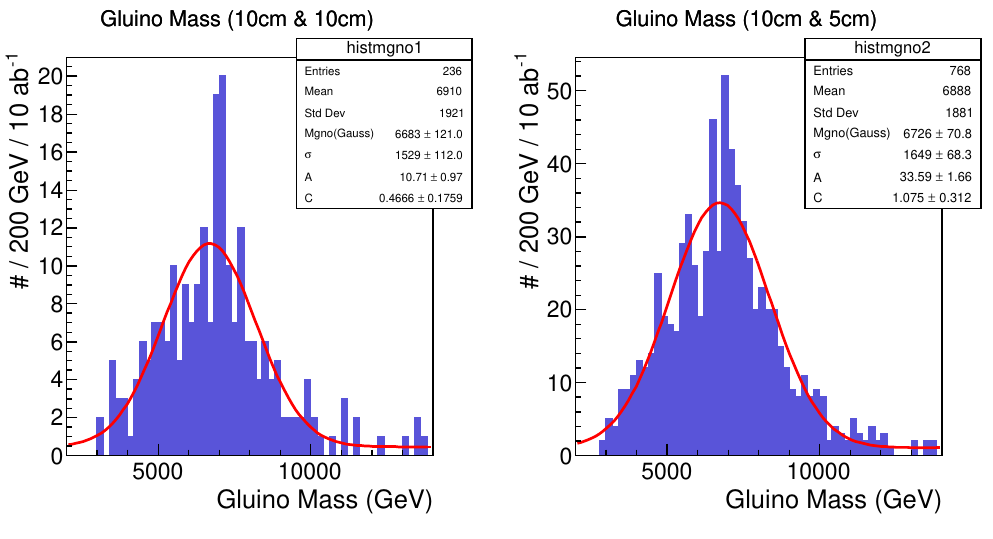
Figure 11 . Distribution of m (rec) in a single experiment with the integrated luminosity of L = 10 ab (cid:0) 1 .